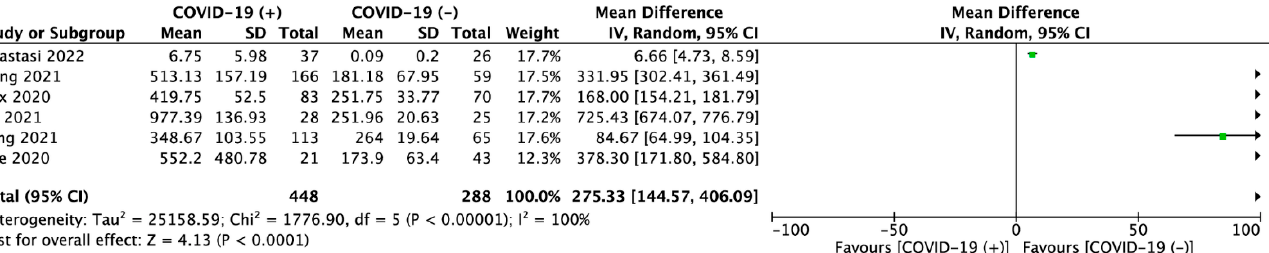
Figure 2. Forest plot of Krebs von den Lungen-6 levels (U/mL) among COVID-19 positive vs. negative patients. The center of each square represents the mean differences for individual trials, and the corresponding horizontal line stands for a 95% confidence interval. The diamonds represent pooled results [12,20–23,27].